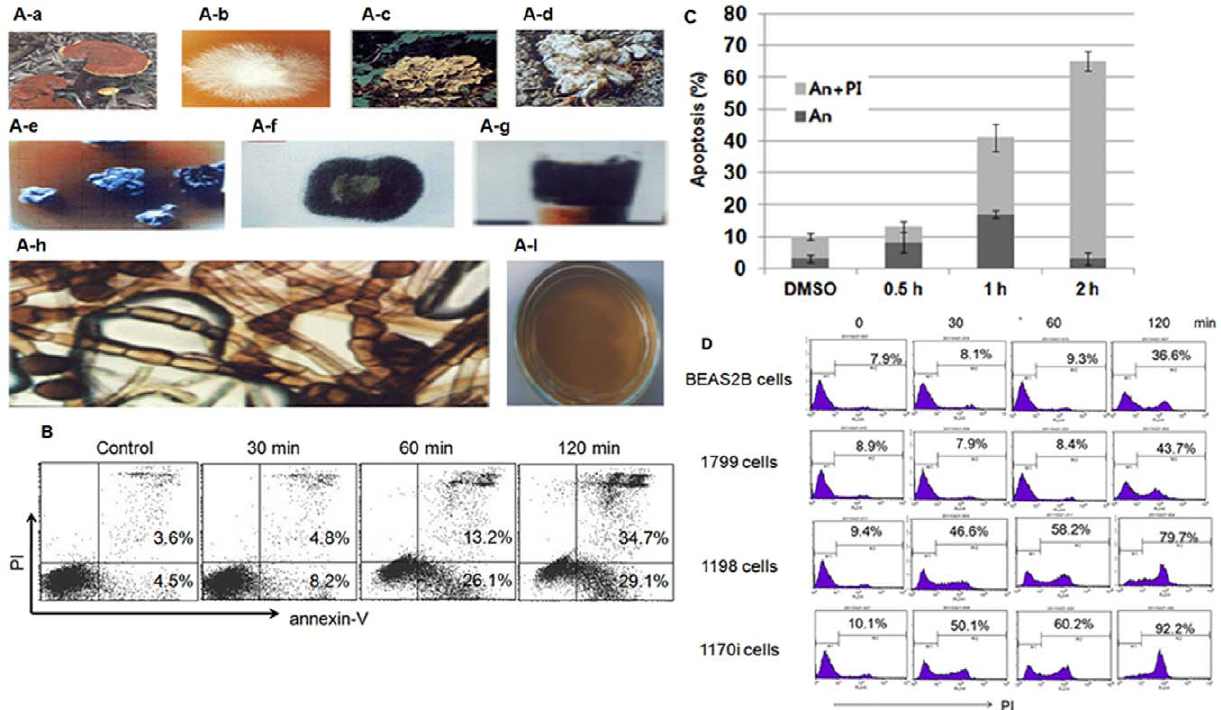
Figure 2. Khz induces apoptosis in transformed cells. (A) (A-a) The shape and type of fused fruiting bodies. (A-b) Hyphae isolated from a Ganoderma lucidum mushroom on a Petri dish. (A-c) Shape of G. lucidum . (A-d) Shape and type of fused fruiting bodies and hyphae from